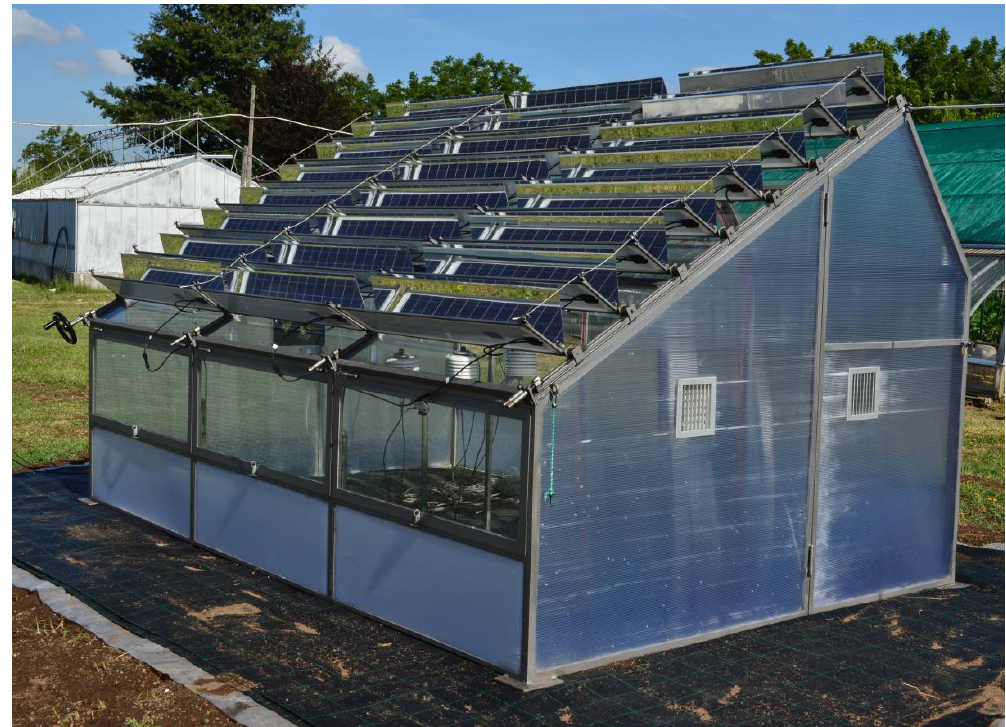
Figure 1. The experimental prototype used for this search.